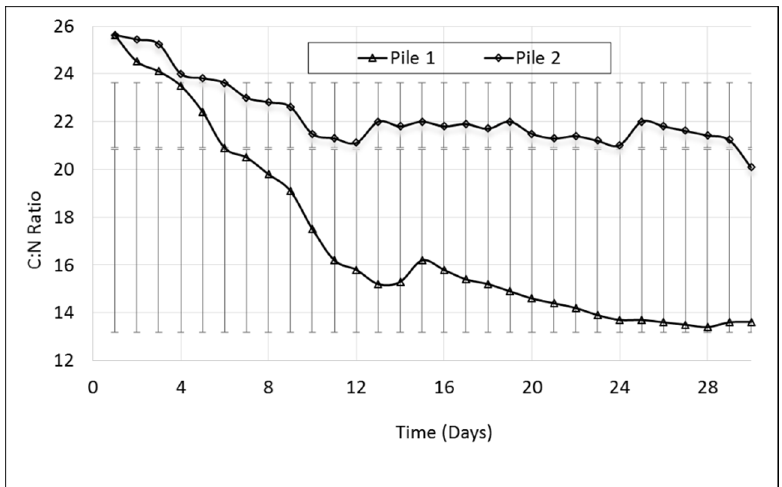
Figure 2. Changes in C:N ratio during composting.